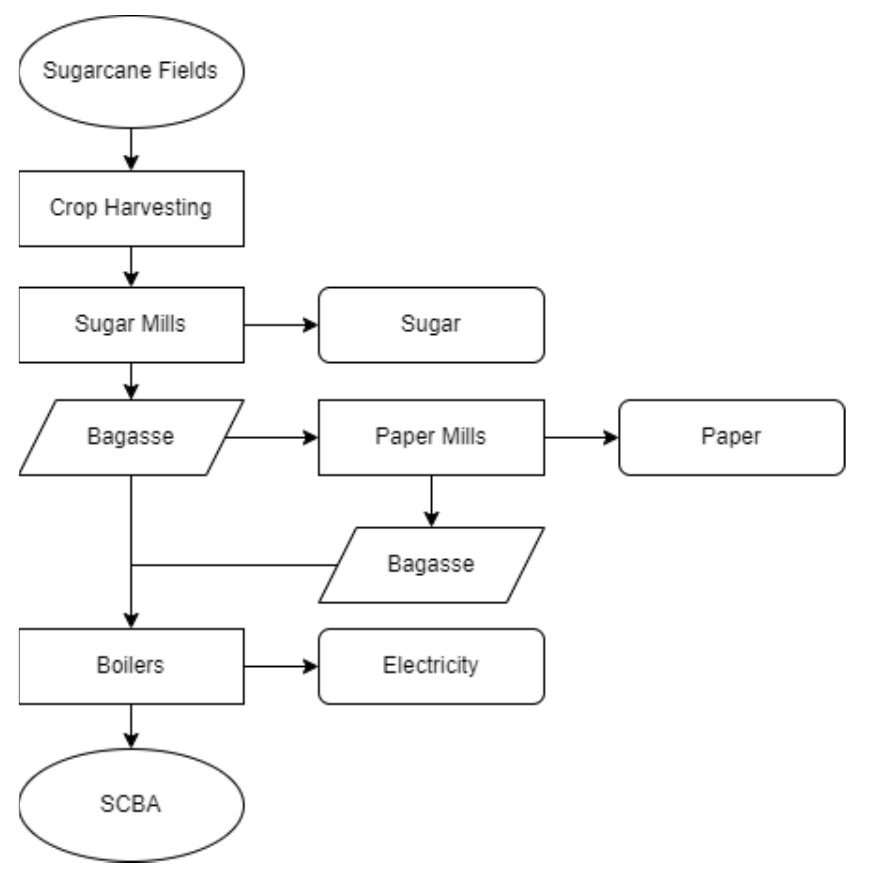
Figure 2. SCBA manufacturing process.